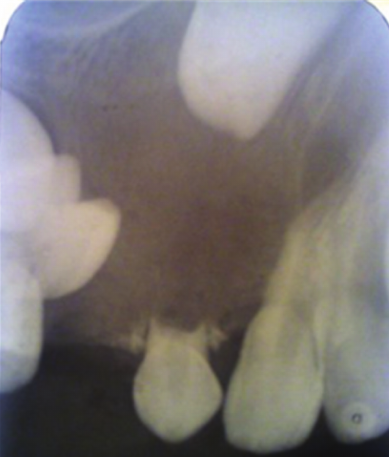
Figure 1: Preop Frontal View.